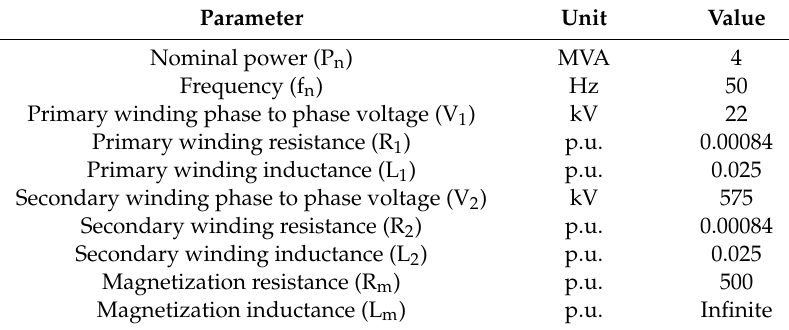
Table A4. Wind farm transformer